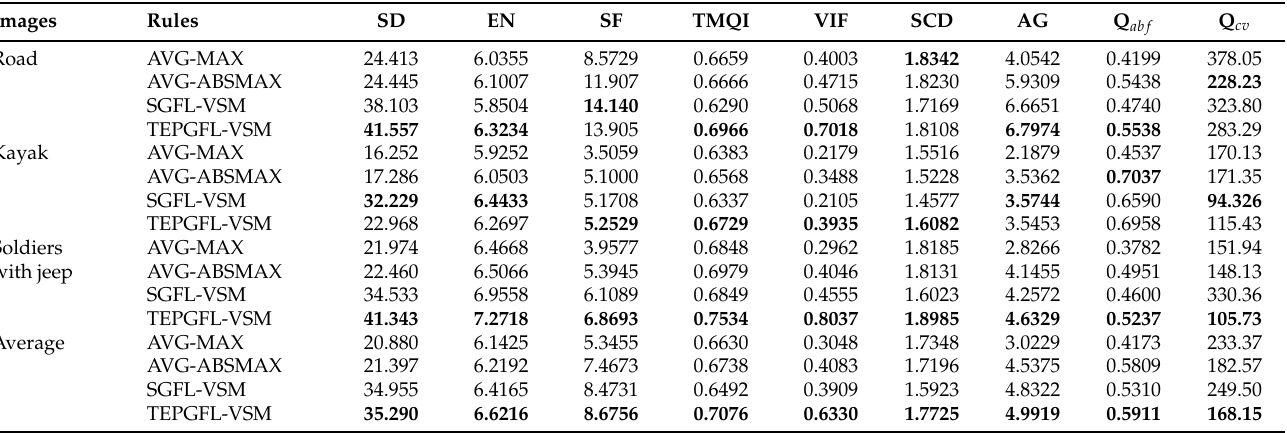
Figure 7. Quality performance comparison on the results of different fusion rules in the MFGS decomposition framework. From top to bottom: ‘Road’, ‘Kayak’, and ‘Soldiers with jeep’. In addition, Table 1 provides the corresponding quantitative evaluation for 3 source image pairs (‘Road’, ‘Kayak’, and ‘Soldiers with jeep’) of various fusion rules. The highest value standing for the best performance is highlighted in bold for each metric except for Q cv . On the contrary, a low value of Q cv indicates that the fused image has a good performance. From the average values of each metric for 3 source image pairs (‘Road’, ‘Kayak’, and ‘Soldiers with jeep’) of various fusion rules in Table 1, our TEPGFL-VSM fusion scheme outperforms three other fusion rules. Table 1. Objective assessments. The metric value marked in bold indicates that the fusion rule achieves the best performance on the current image pair. “Average” means the average values of each metric for 3 source image pairs (‘Road’, ‘Kayak’, and ‘Soldiers with jeep’) of various fusion